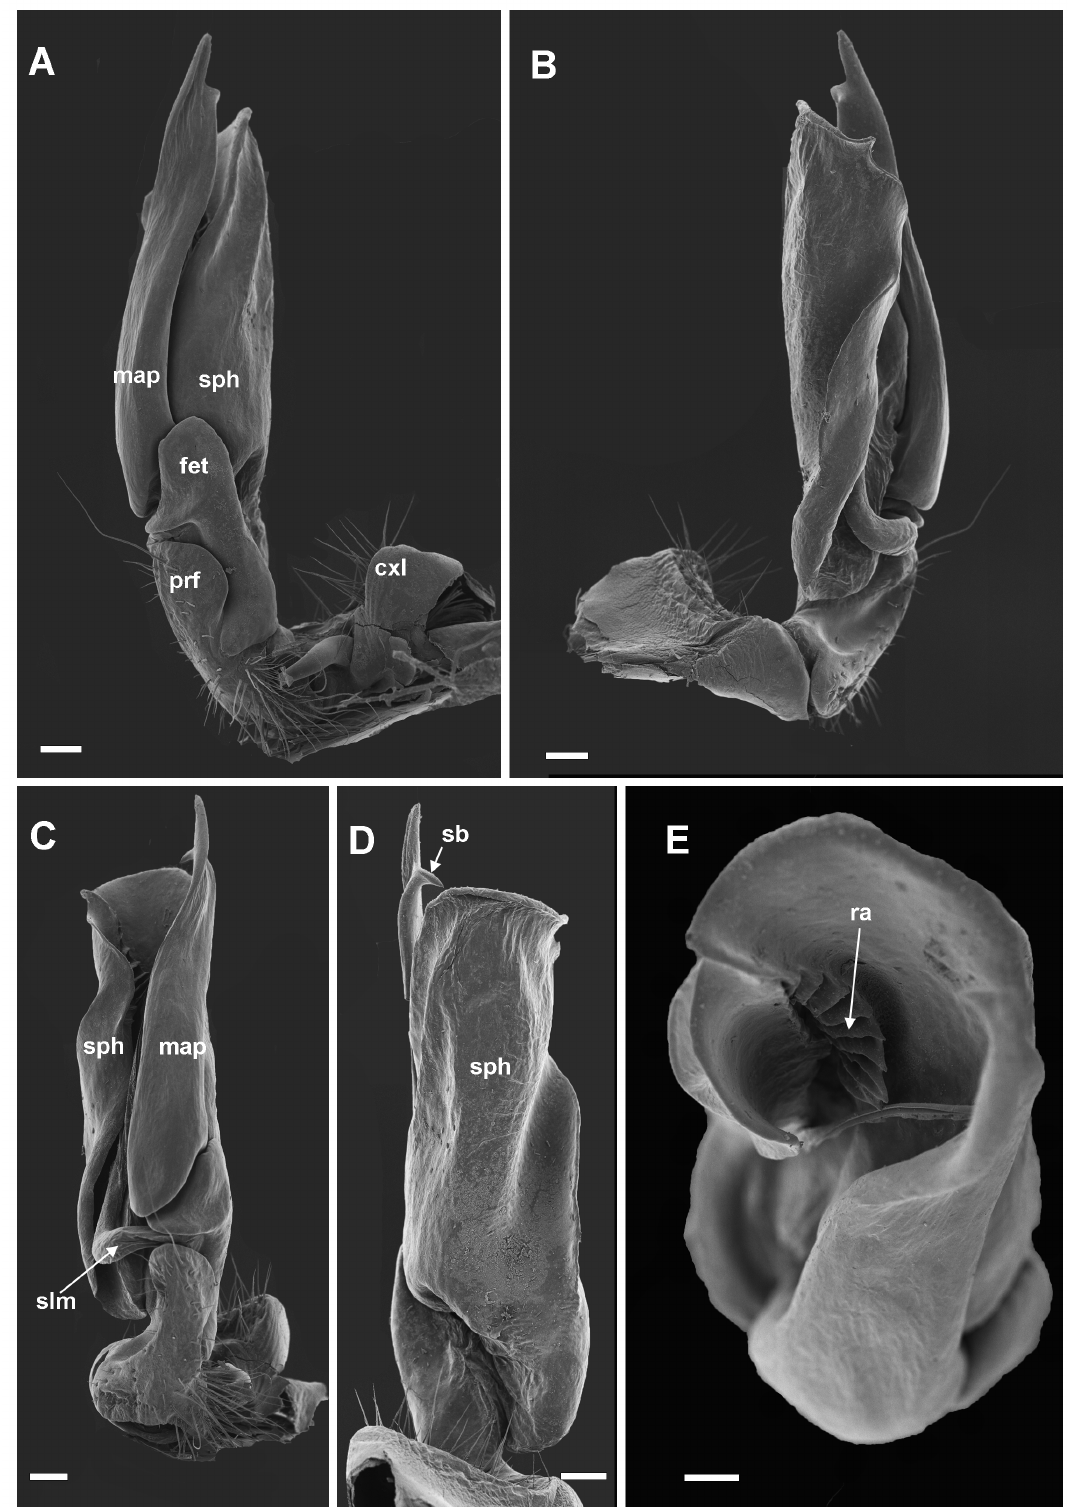
Fig. 33. Eviulisoma articulatum sp. nov., holotype, right gonopod. A . Mesal view. B . Lateral view. C . Ventral view. D . Dorsal view. E . Acropodite, distal (-anterior) view. Abbreviations: cxl = coxal lobe; fet = ʻfemoriteʼ; map = mesal acropodital process; ra = ridged area on internal surface of sph ; sb = side branch of map ; slm = solenomere; sph = solenophore. Scale bars: A–D= 0.1 mm; E = 0.05